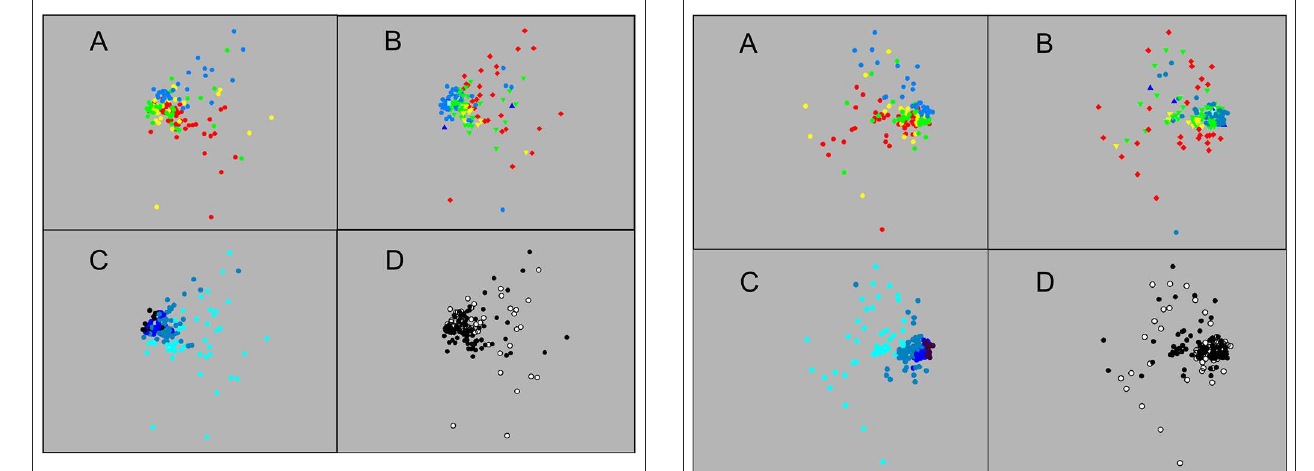
FIGURE 3 | Ordination of the 148 sets based on catch data in numbers: (A) Sets identified by survey—red: 2007, yellow: 2008, green: 2009, blue: 2010; (B) Sets identified by station—red: Head, yellow: Wall, green: Main, light blue: Slope, medium blue: Deep, dark blue: Offshore; (C) Sets identified by maximum depth reached—light blue: 250m, medium blue: 750m, dark blue: > 750 and ≤ 1,250m, black: > 1,250m; (D) Sets identified by diel phase—open circle: daylight, filled circle: night (MDS 2D stress 0.14).